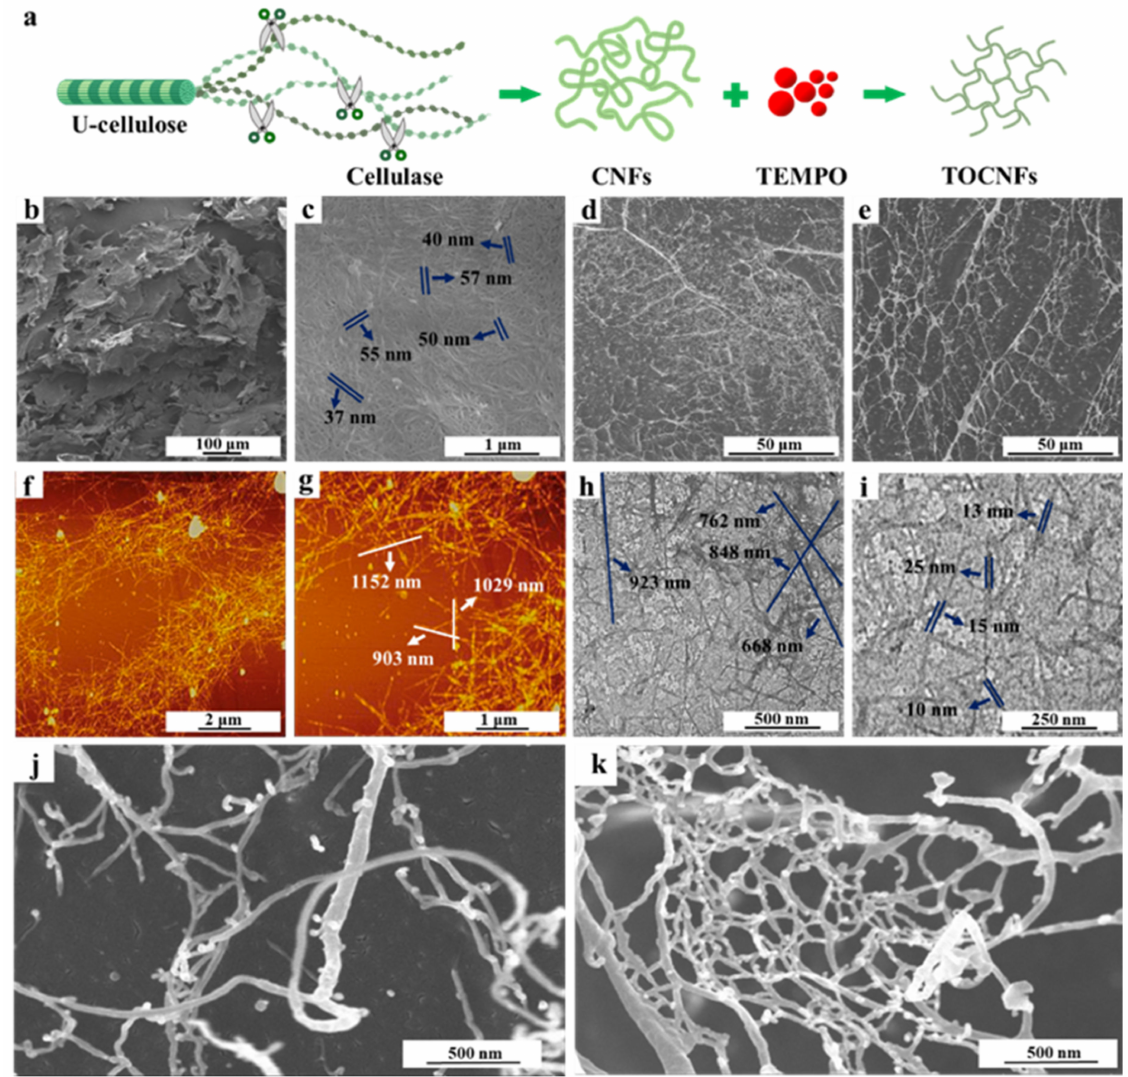
Figure 1. Schematic illustration for the preparation of nanocellulose ( a ). SEM images of U-cellulose ( b , c ), CNFs ( d ), and TOCNFs ( e ); AFM images of CNFs ( f , g ); TEM images of TOCNFs ( h , i ); amplified SEM images of CNFs ( j ) and TOCNFs ( k